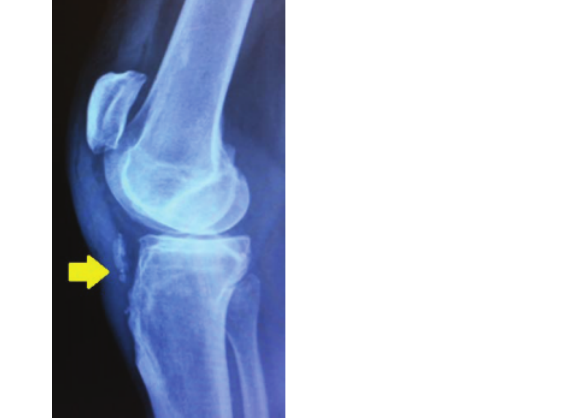
Figure 1: Injury film showing high patella and presence of calcifica- tion in the distal part of the patellar tendon (arrow).